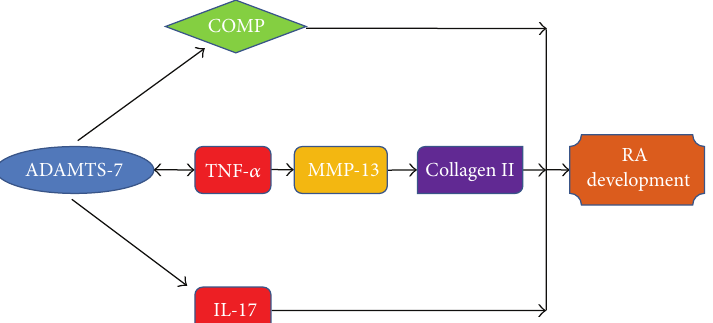
Figure 3: A proposed model for the potential role and regulation of ADAMTS-7 in the pathogenesis of inflammatory arthritis (edited according to